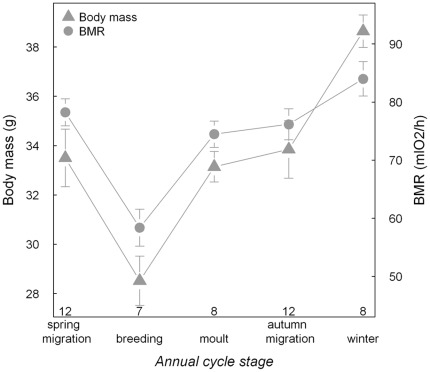
Body mass and mass-specific basal metabolic rate (BMR) of control skylarks throughout the annual cycle.Body mass measurements were taken in the mornings upon completion of the metabolic measurements. Numbers represent samples sizes.